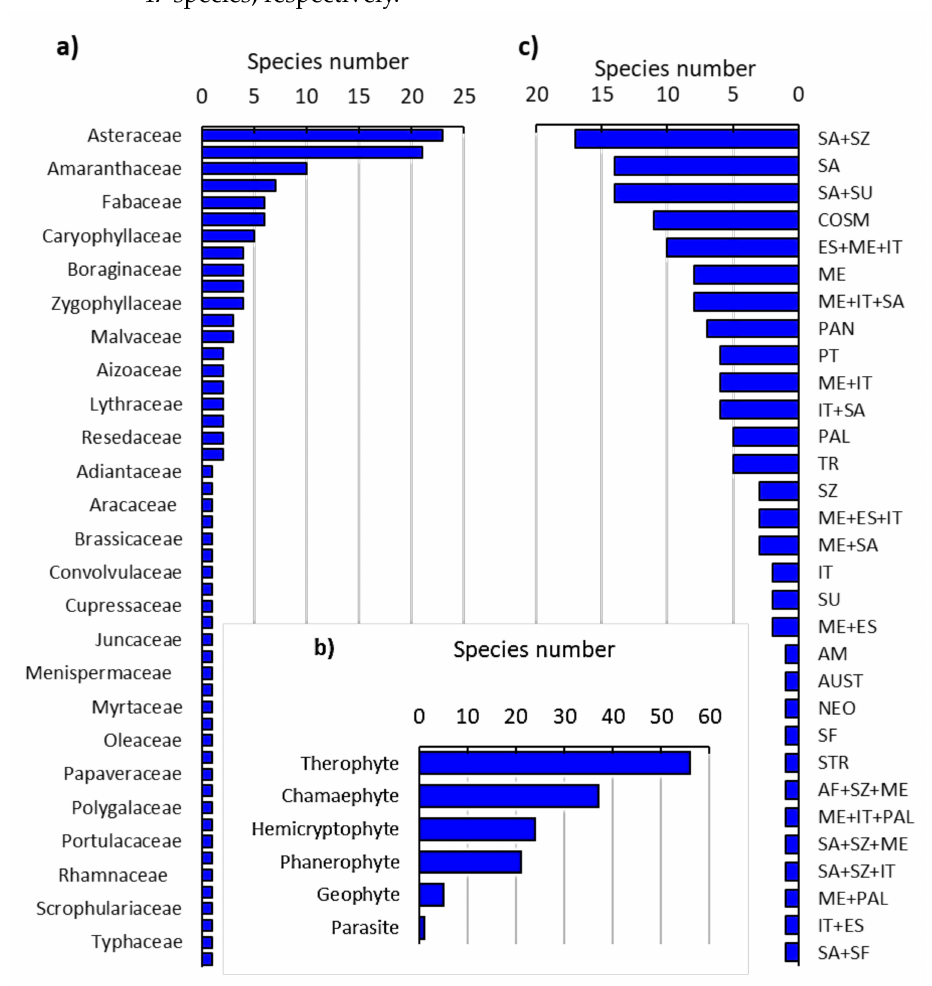
Figure 1. Floristic composition of the habitats invaded by Nicotiana glauca in the Taif region, western of Saudi Ara- bia. ( a ) Identified plant families, ( b ) life forms, and ( c ) chorotype spectra. ME: Mediterranean, COSM: Cosmopolitan, SU: Sudanian, SA: Saharo-Arabian, AM: American, TR.: Tropical, ES: Euro-Siberian, IT: Irano-Turanian, AU: Australian, SZ: Sudano-Zambezian, Pan: Pantropical, PAL: